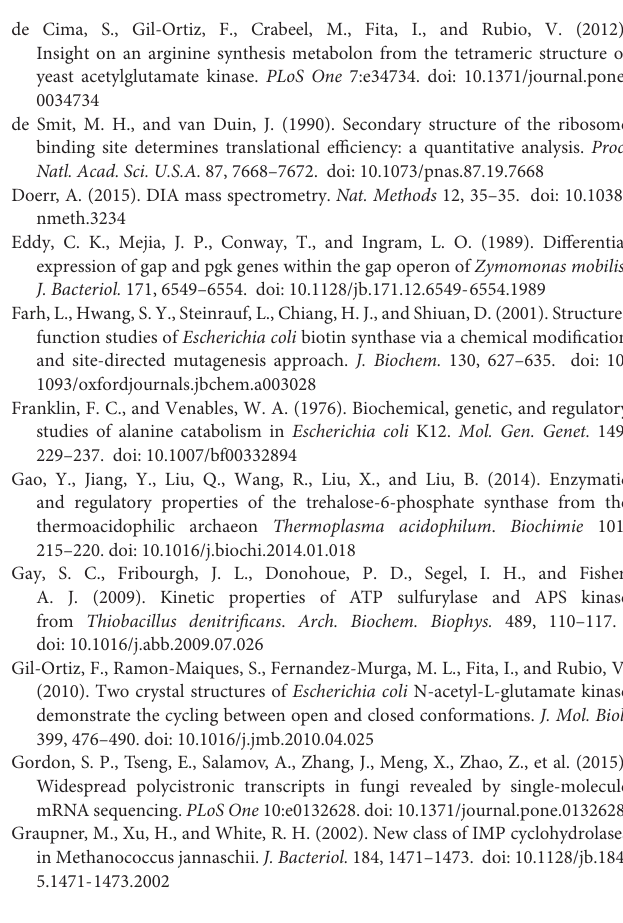
FIGURE S1 | Physical and chemical features of quantified and unquantified proteins in E. coli . Panels (A–D) are distributions of protein isoelectric point, instability, protein length, and hydrophobicity. Instability tests a protein for stability, which value above 40 means the protein has a shorter half-life. The Kolmogorov–Smirnov test (KS-test) was used to test the distribution between quantified and unquantified proteins. Significance different were found between quantified and unquantified proteins indicated different physical–chemical characterizations of them. FIGURE S2 | CV within operons of measured data and randomized negative control at RNA level.